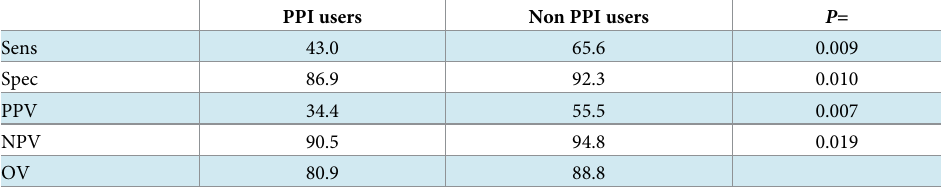
Table 3. Diagnostic accuracy of positive faecal immunochemical test (FIT (cid:21) 20 μg/g) for advanced neoplasia according to PPI